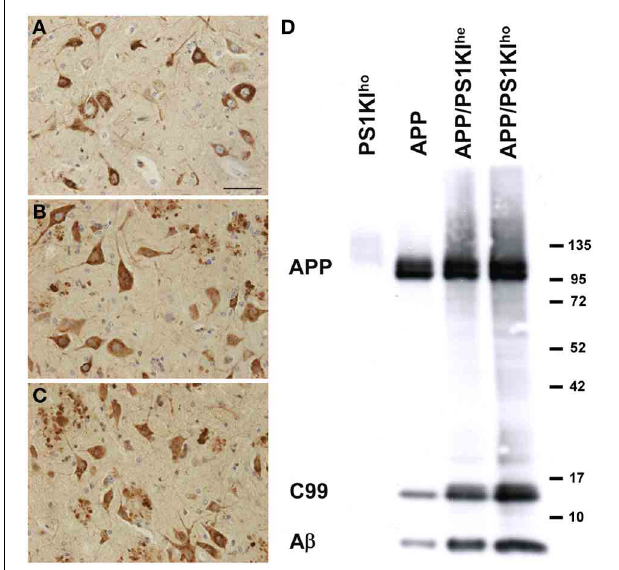
FIGURE 1 | Immunostaining of human APP using 22C11 in spinal cords of APP (A), APP/PS1KI he (B), and APP/PS1KI ho (C) mice showing comparable numbers of APP-expressing cells in all three genotypes. Western-blot analyses using W0-2 revealed no differences in the amount of human full-length APP among the three genotypes, however, the levels of C99 and A β increased with increasing PS1KI gene dosage (D) . Scale bar: 50 μ